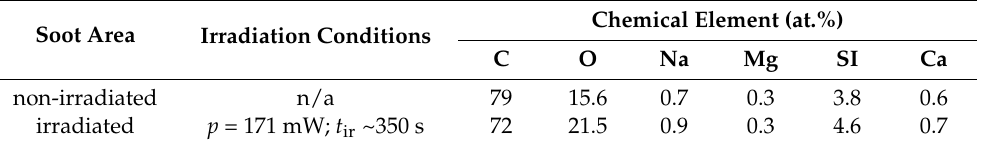
Table 1. Chemical composition of each group soot coatings defined by EDS with an experimental uncertainty within ±0.1 at.%. The elements Na, Mg, Si and Ca are associated with the chemical composition of the glass substrate itself.